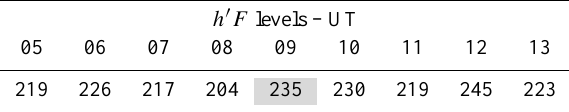
Table 4. LS-TID event at MAUI (26 October